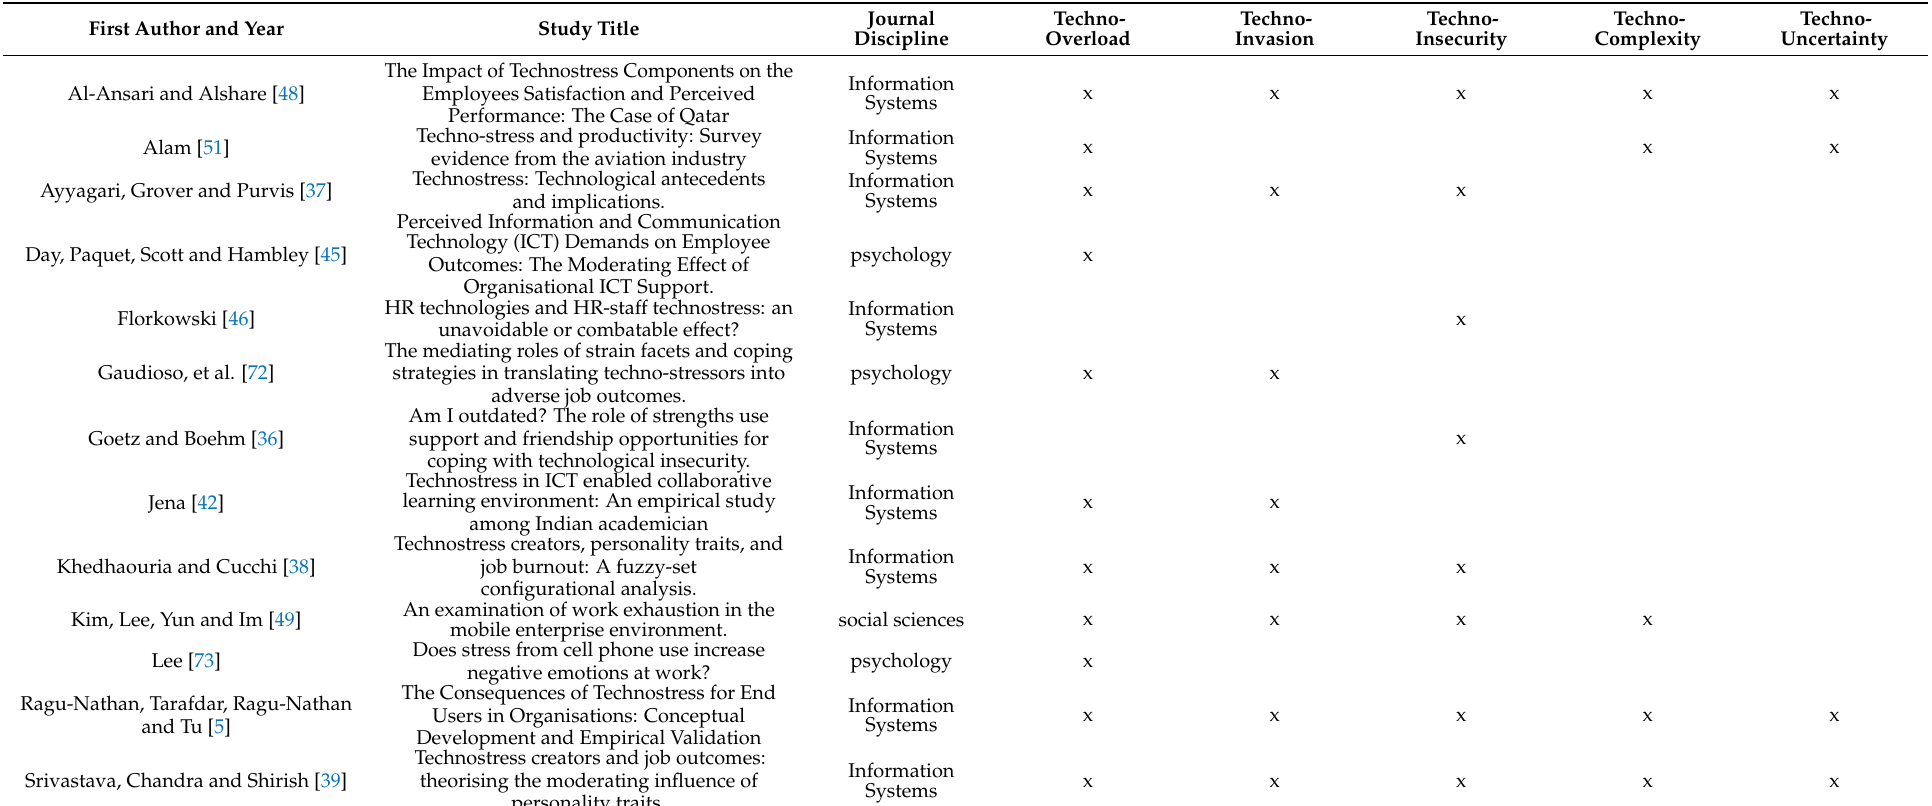
Table A1. List of included